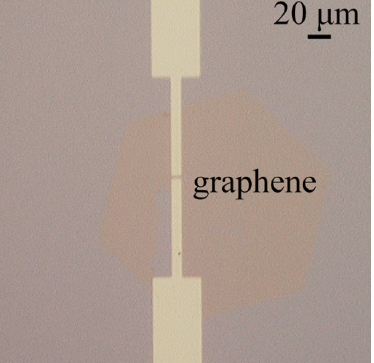
Figure 1. Optical image of a hexagonal graphene assembled onto a pair of microelectrodes.